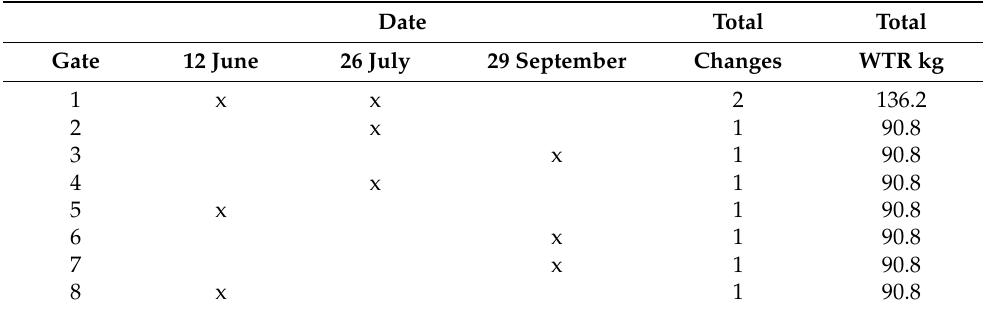
Table 4. Cartridge Refresh Frequency and WTR Used During 2020. “x” denotes date that cartridge was